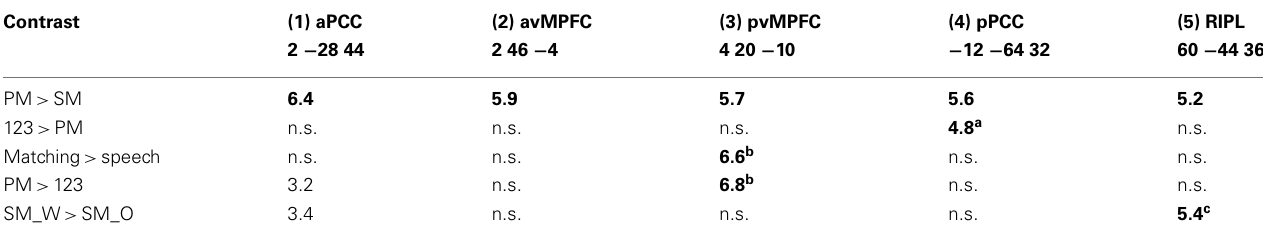
Table 1 |The differential effect of language processing in the five regions of interest.